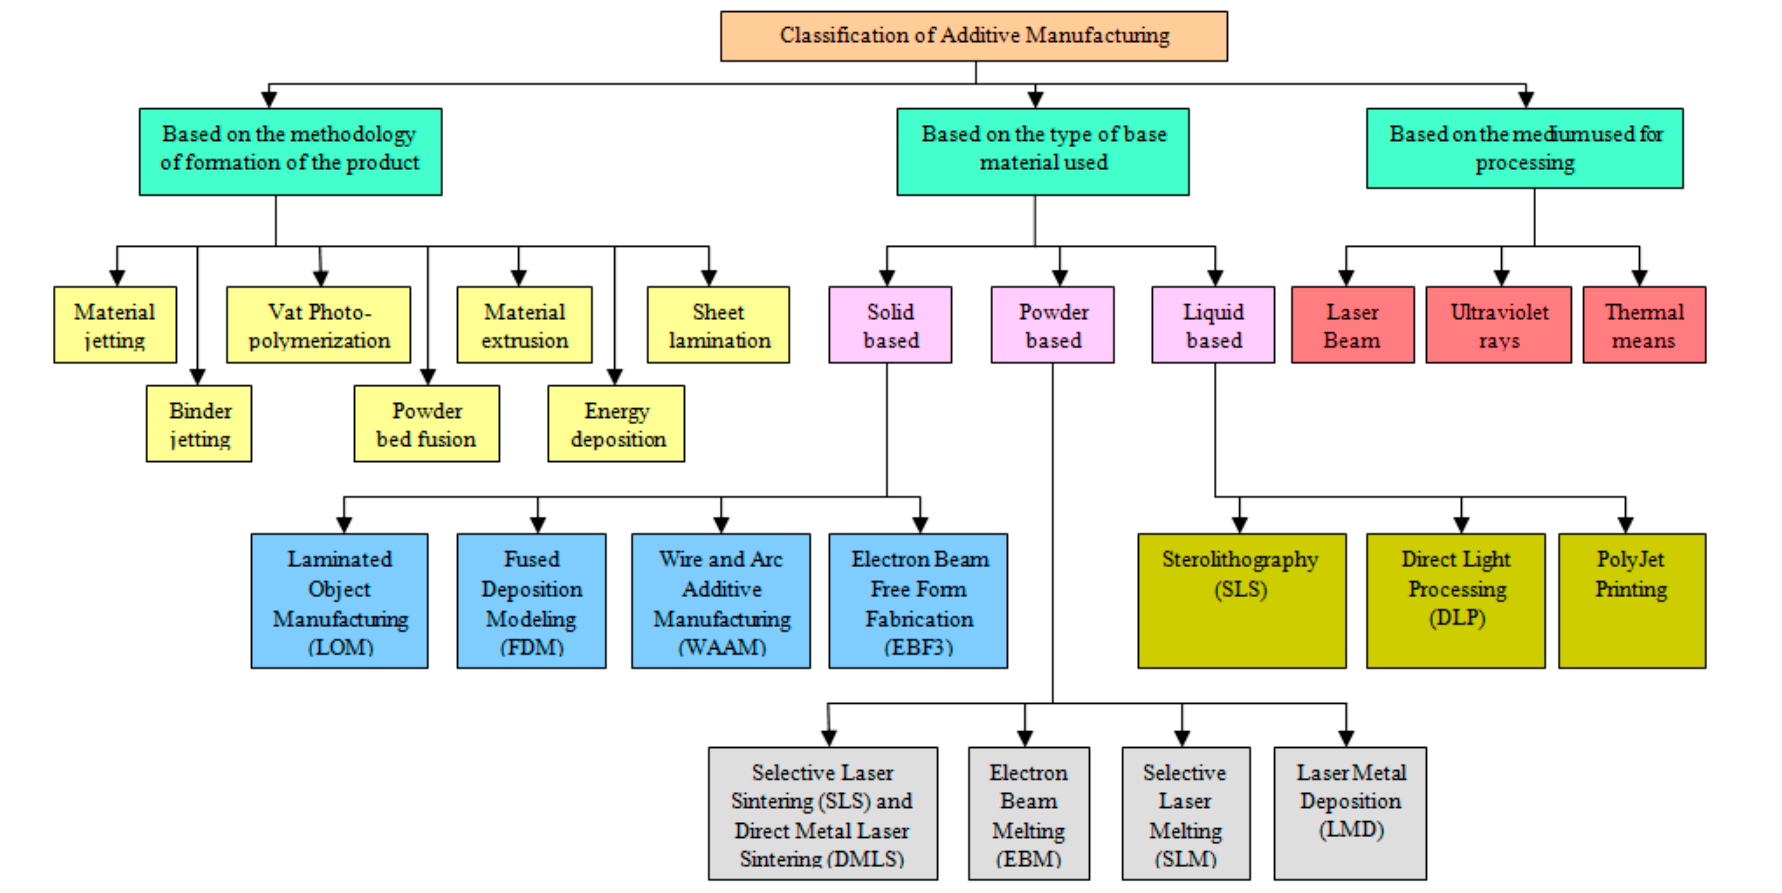
Figure 3. Classification of additive manufacturing processes from different contexts.